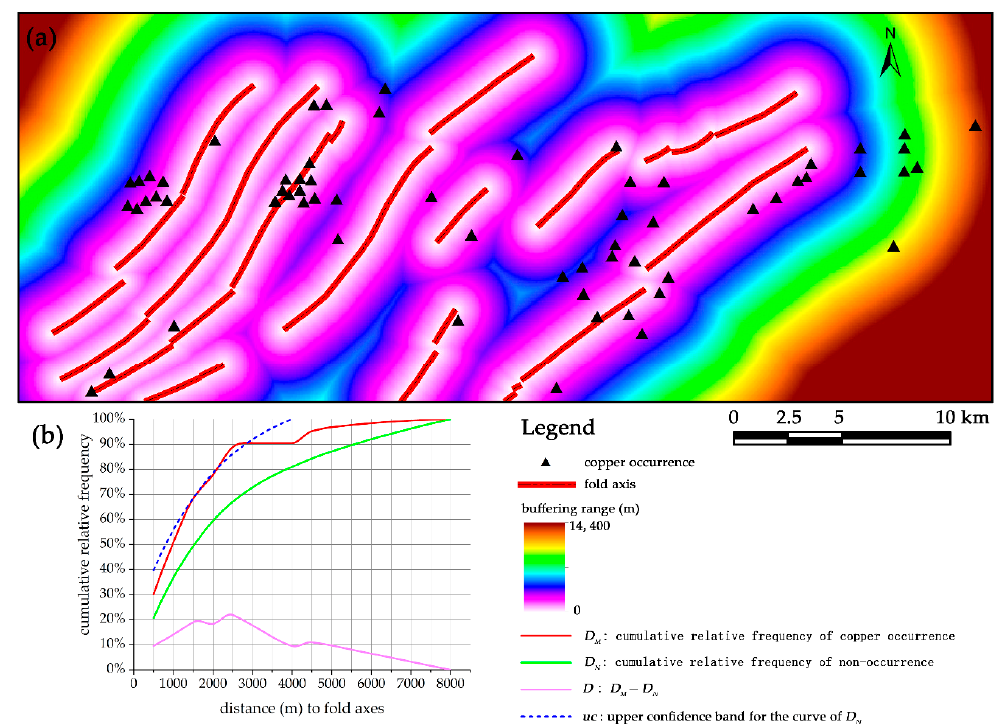
Figure 9. ( a ) Buffer analysis and ( b ) graph of cumulative relative frequency concerning distance to folds.